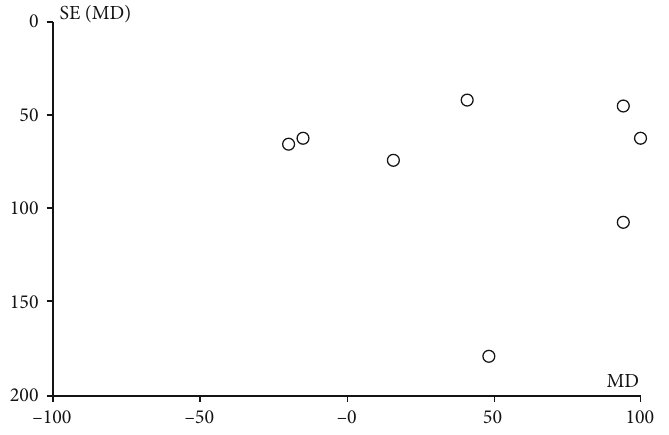
Figure 16: Funnel plots: birth weight (insulin vs.